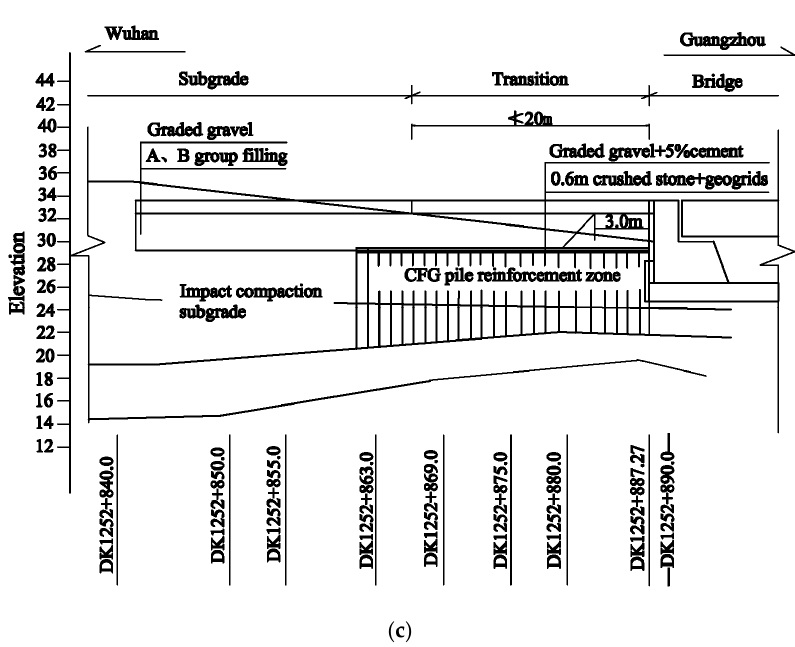
Figure 1. Profile of bridge–embankment transition section (unit: m): ( a ) China’s medium- and long-term railway network planning (https://upload.wikimedia.org/); ( b ) a bridge transition section of Wuhan–Guangzhou high-speed railway; ( c ) a road bridge transition section in Xianning.